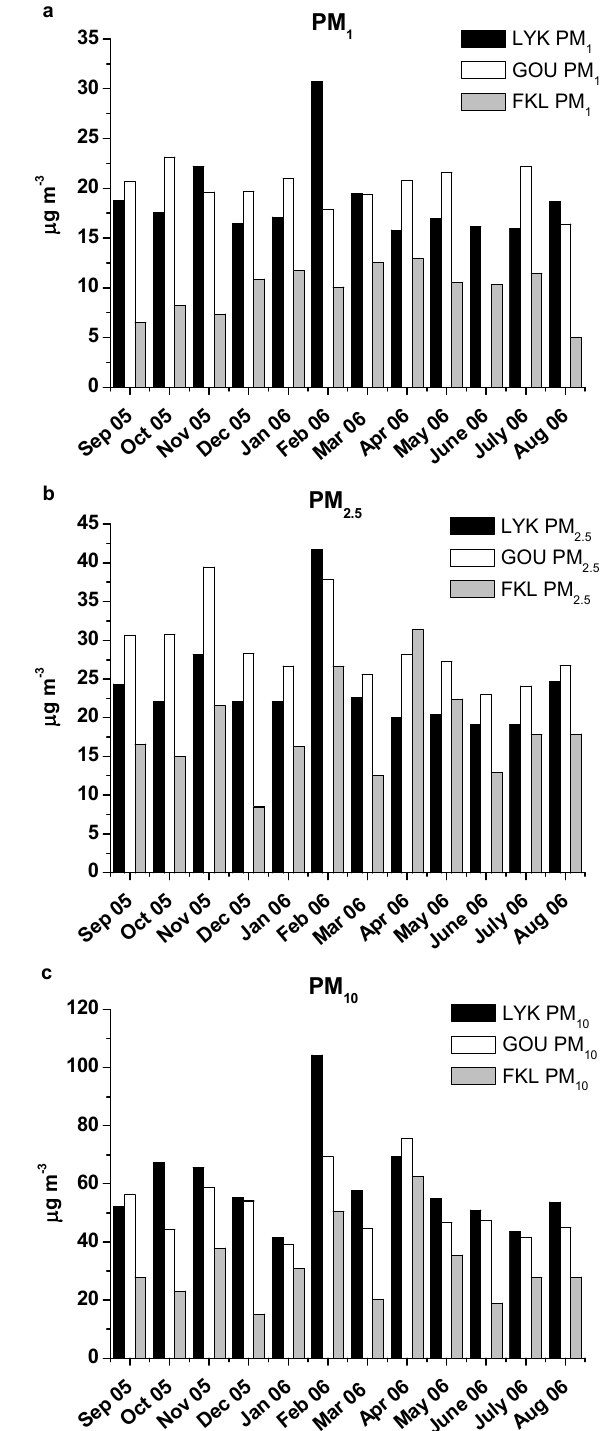
Fig. 4. Temporal variability of size segregated concentrations (µgm − 3 ) (a) PM 1 , (b) PM 2 . 5 and (c) PM 10 for all three stations: LYK, GOU and